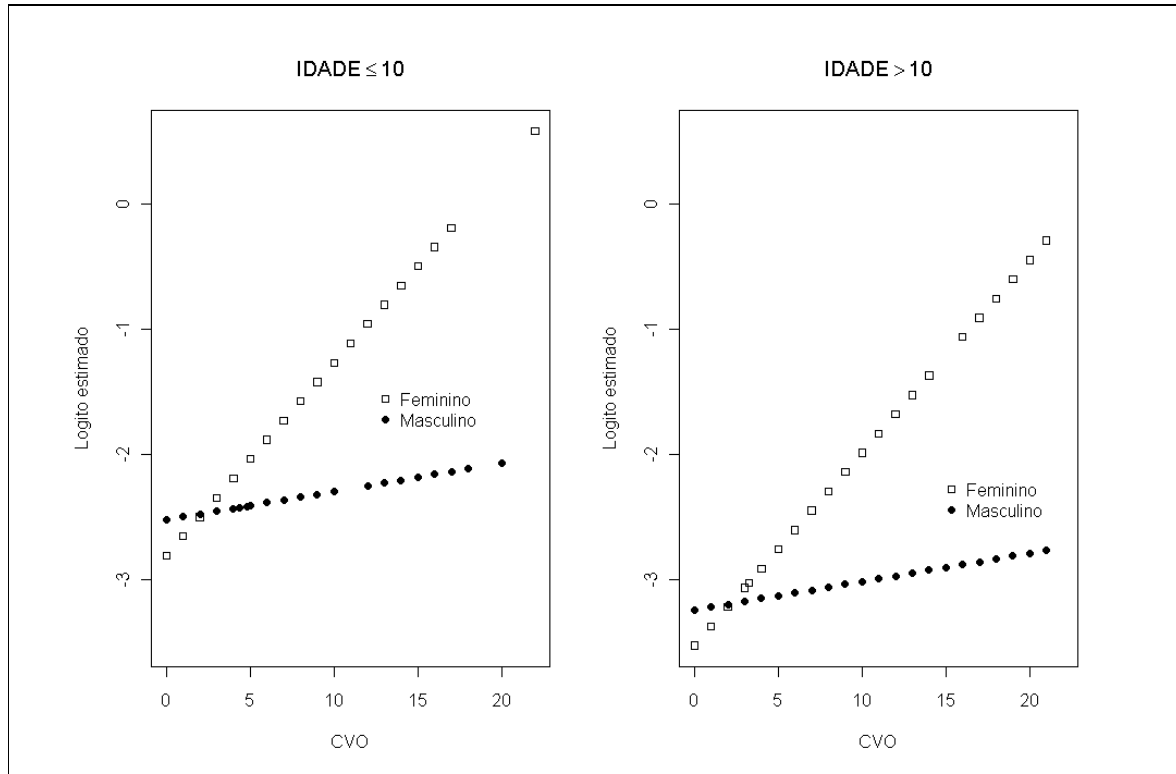
Figura 2 . Interação de Violência Comunitária (CVO) e Sexo nos Sintomas de TEPT para crianças e adolescentes com idade menor ou Igual a 10 anos e maiores de 10